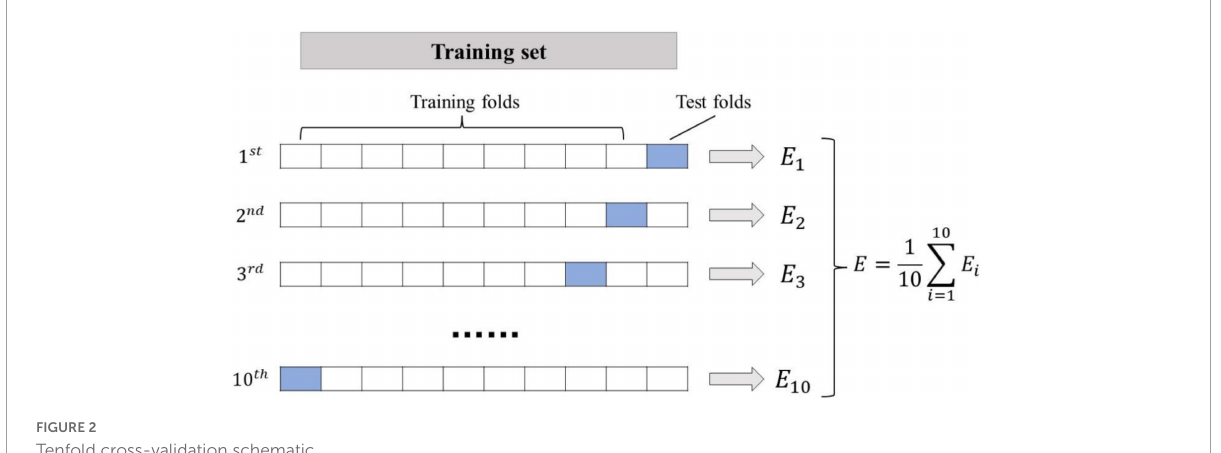
FIGURE2 Tenfold cross-validation schematic.